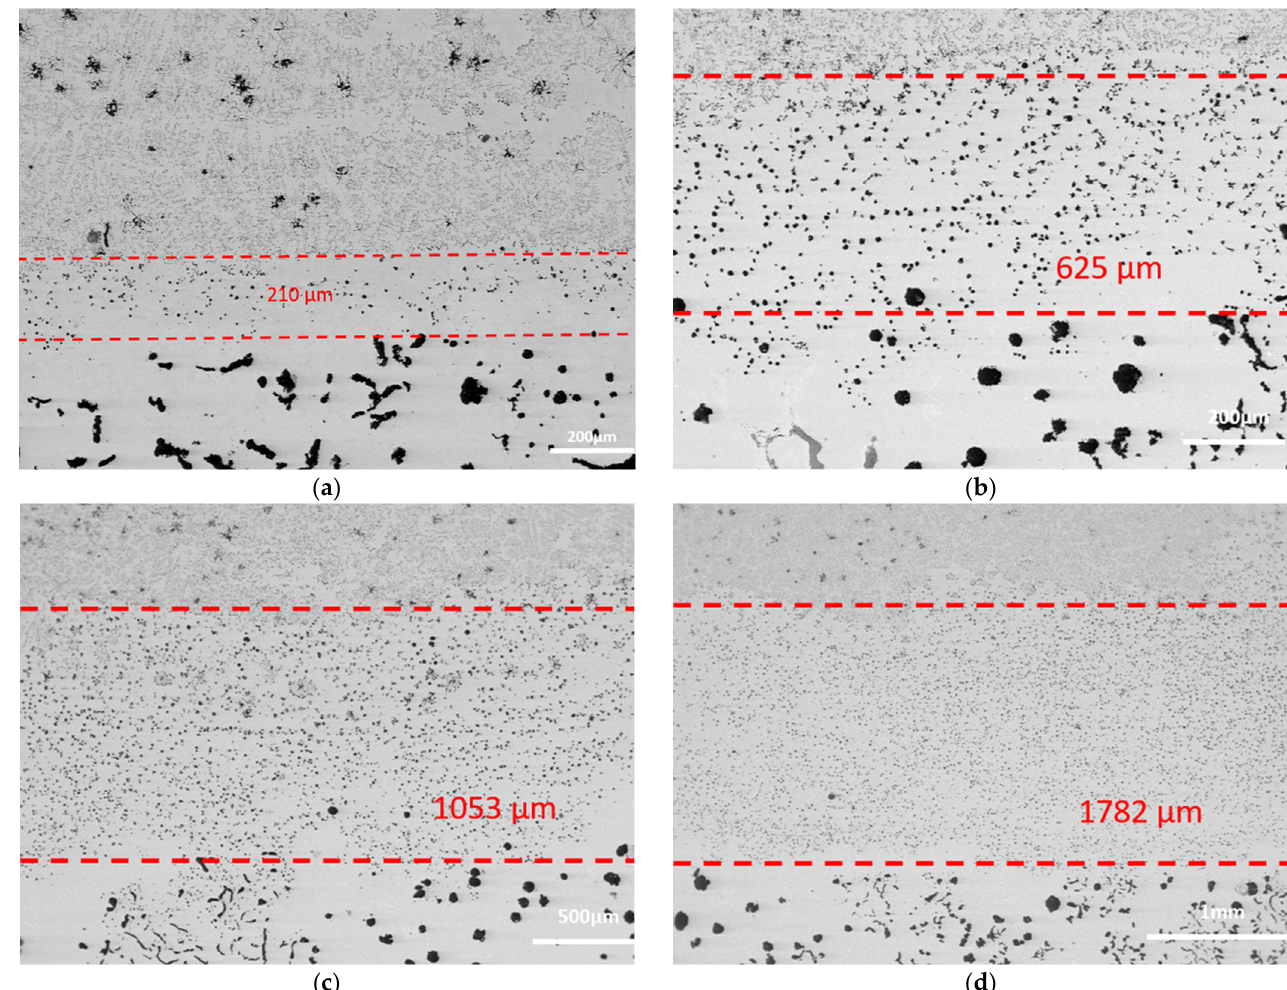
Figure 5. Microstructure of the bonding zone: ( a ) 45 A, ( b ) 50 A, ( c ) 55 A, ( d ) 60 A.